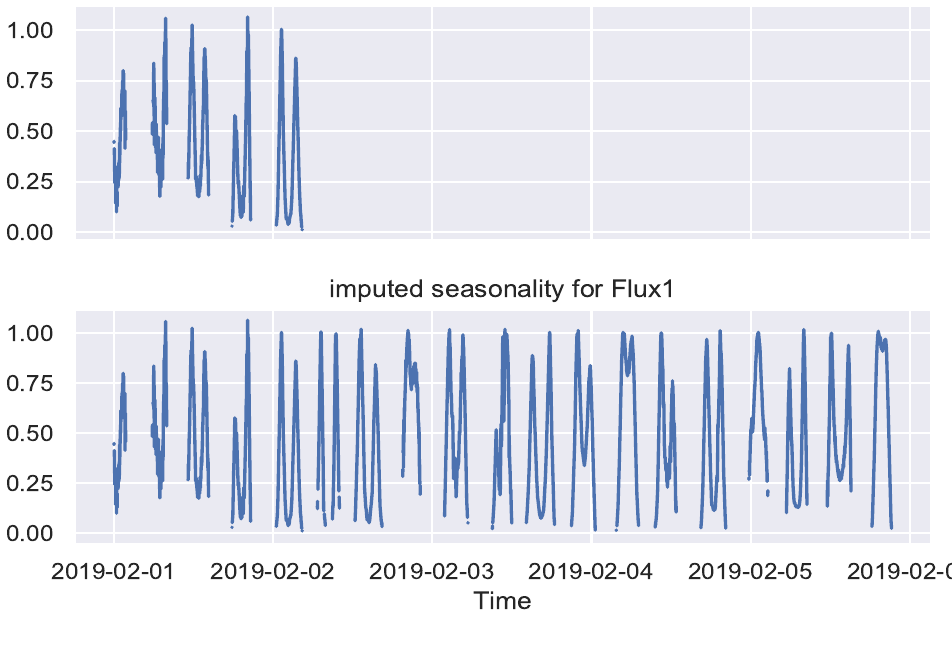
Figure 9. Top panel: Seasonality (detrended part) of original Beidou MEO data (contain lots of missing data); Bottom panel: Seasonality of imputed data (the missing data have been imputed). Showing Flux1 from 2019-02-01 to 2019-02-05.